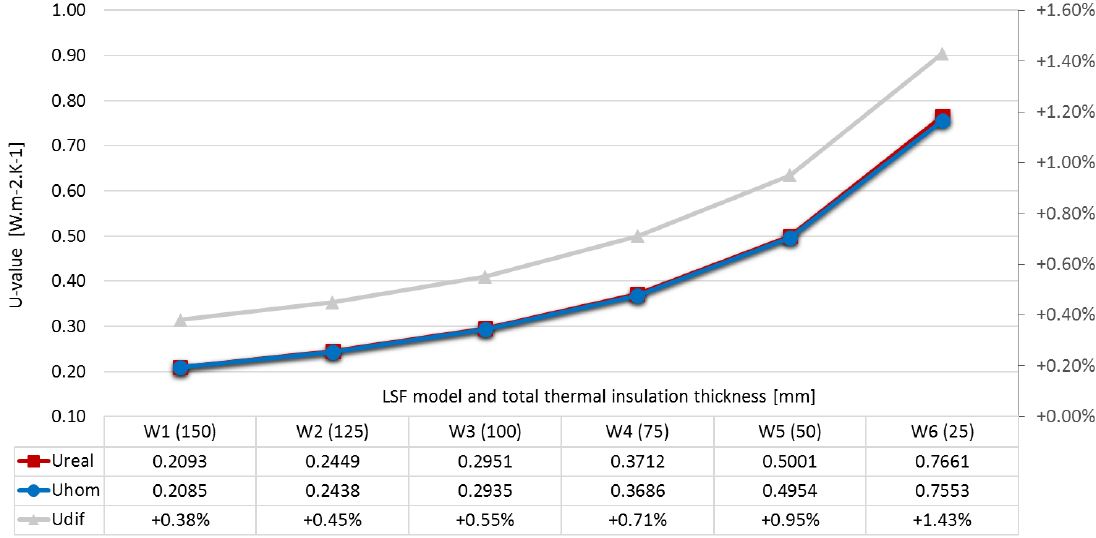
Figure 6. Thermal transmittance values obtained for LSF warm frame construction.